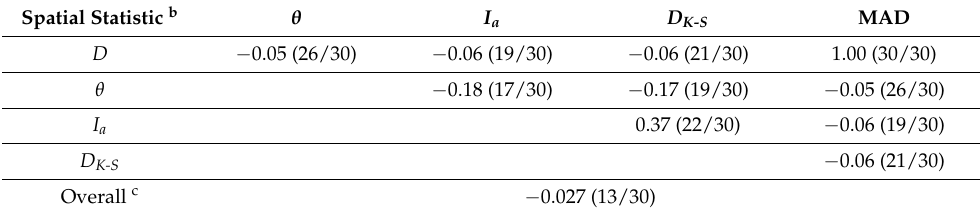
Table 2. Cohen’s and Fleiss’s Kappa agreement and proportions of fields with the same classification for the index of aggregation ( D ), β -binomial distribution, index of aggregation ( I a ) of Spatial Analysis by Distance IndicEs ( SADIE ), events and intervals ( D K-S ) and Maximum Absolute Deviation (MAD) test from L ( d ) function for 30 fields assessed for Fusarium wilt of banana (FWB) incidence in Brazil a . Spatial Statistic b θ I a D